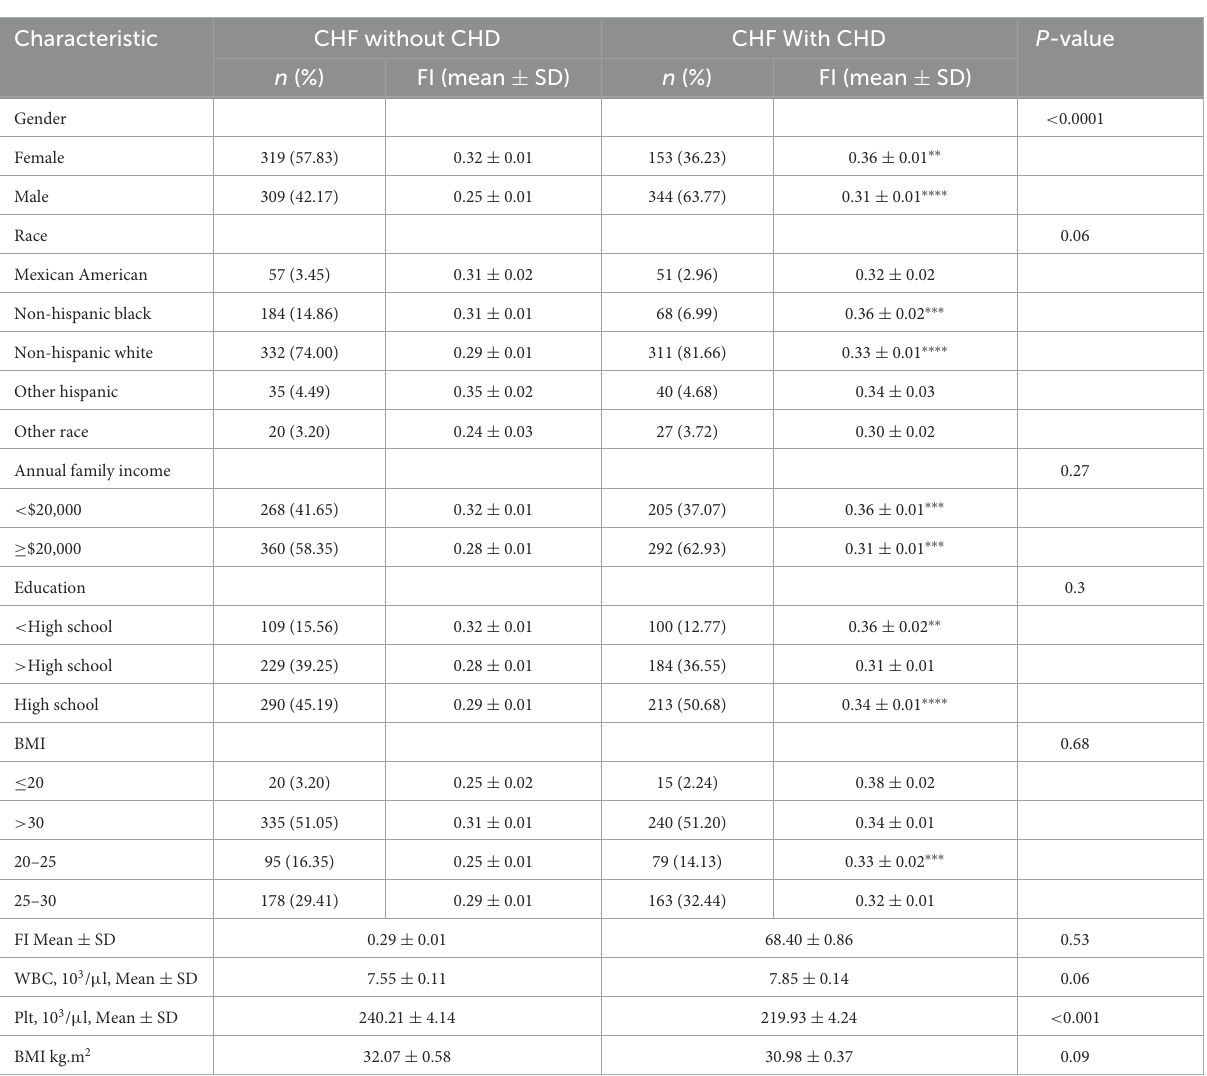
TABLE 4 Subgroup analysis for CHF with CHD.